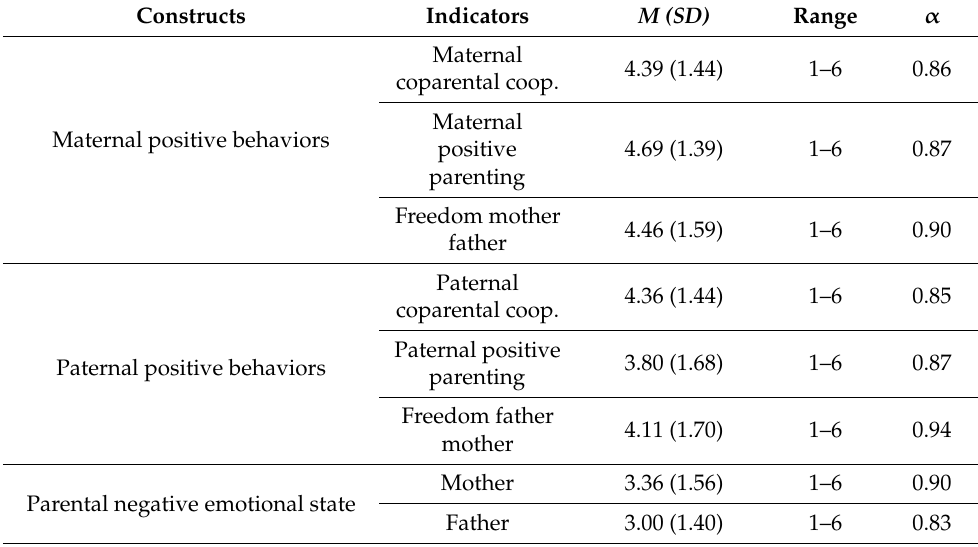
Table 1. Descriptive information for study